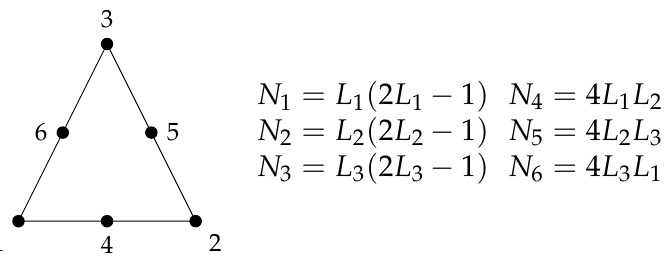
Figure 1. 6-noded triangle finite element with quadratic interpolation L 1 , L 2 and L 3 are the linear combination of the triangle area coordinates and N 1 , N 2 , N 3 , N 4 , N 5 and N 6 are the resulting shape